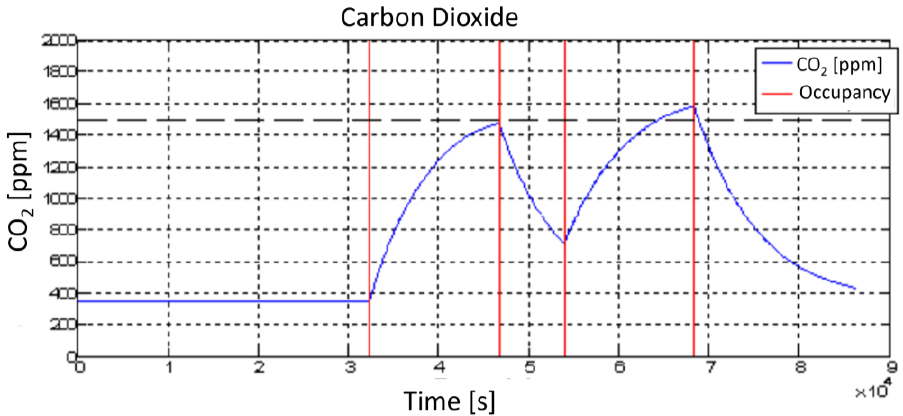
Figure 16. Modelization results on IAQ variables: CO 2 .